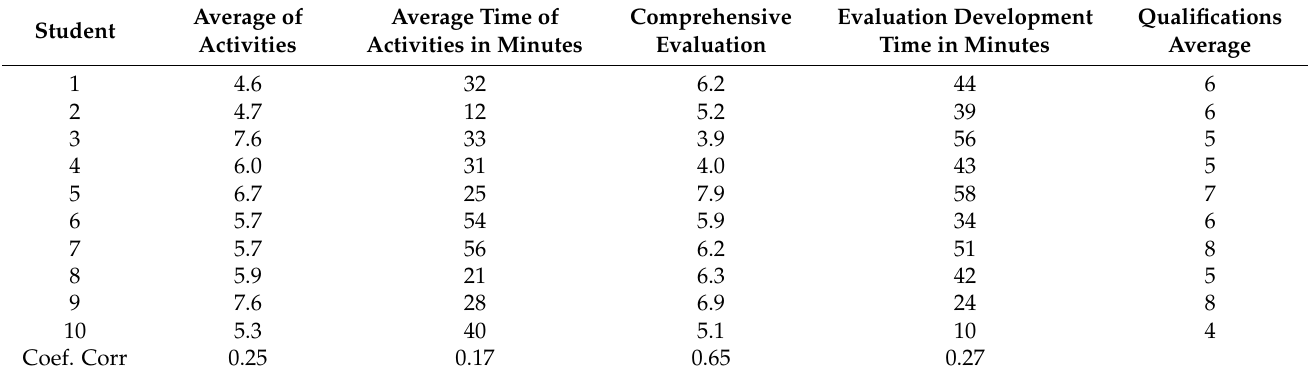
Table 2. Results of data processing, classification of activities, score of the comprehensive evaluation period versus development times